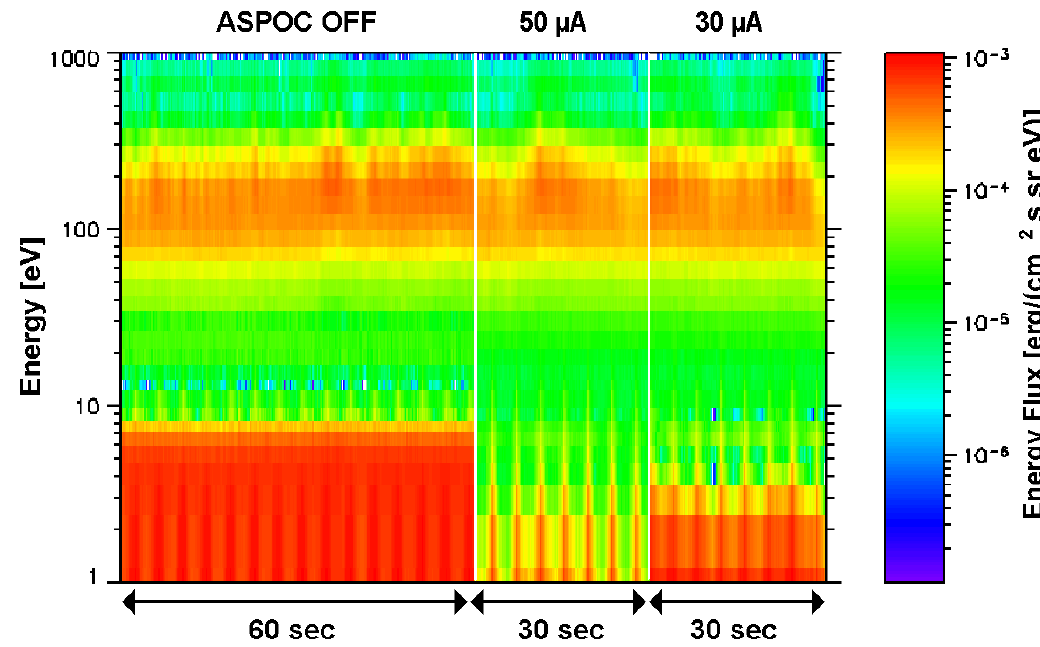
Fig. 7. PEACE electron spectrograms on 2 March 2004, shortly after 10:00 UT, for different ASPOC ion beam currents.